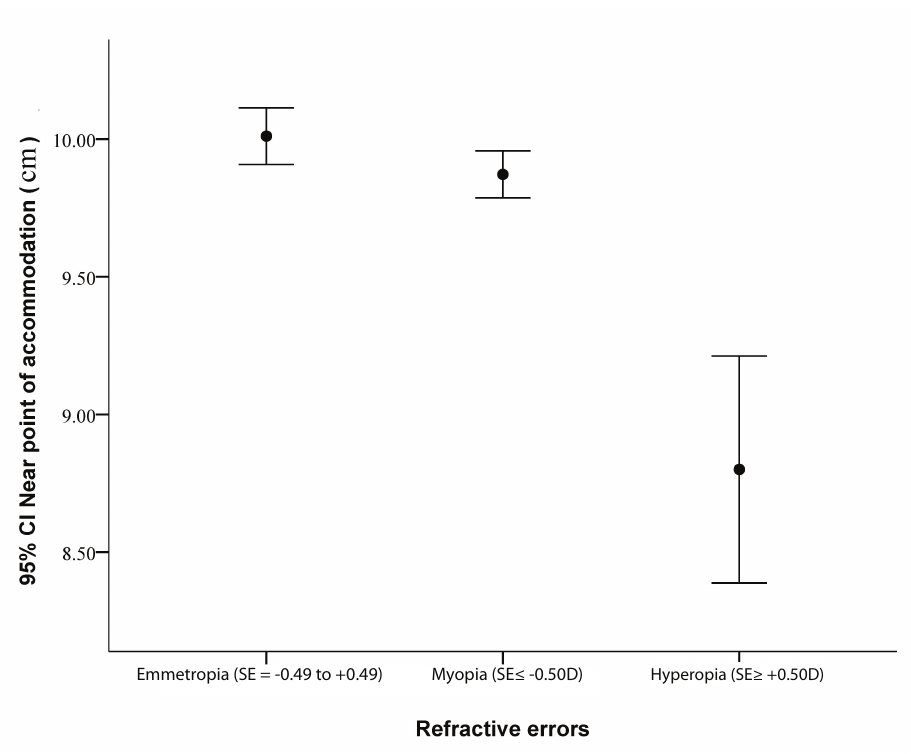
Figure 2. The near point of accommodation in different refractive errors. SE, spherical